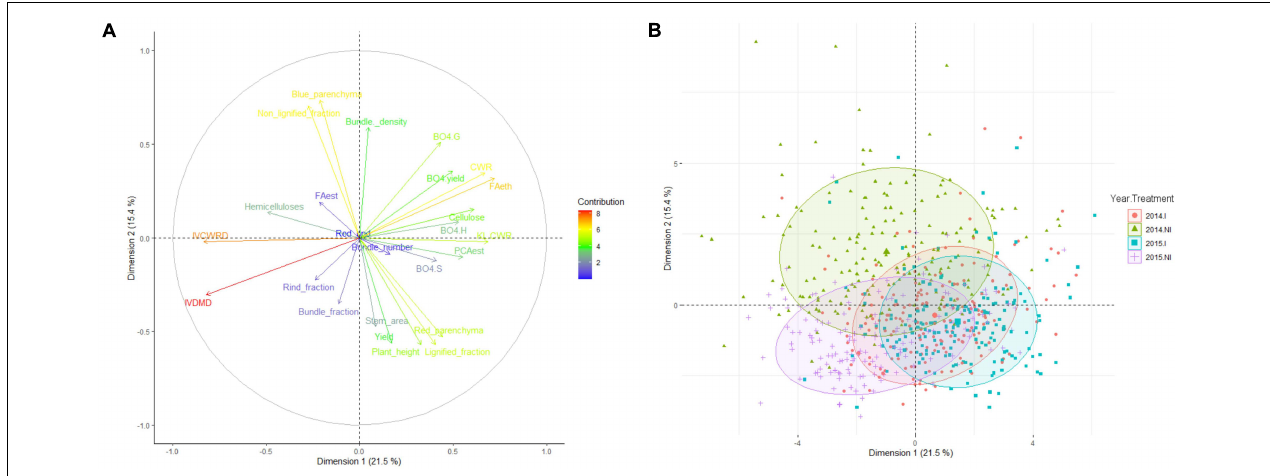
FIGURE 1 | PCA analysis including histological, biochemical, and agronomical traits quantified. (A) Representation of the contribution of each trait in dimension 1 (21% of the global variance) vs. dimension 2 (16.3% of the global variance). (B) Projection of each recombinant inbred line for each year and each irrigation scenario in dimension 1 and 2 area of the PCA analysis. Circles represent the area occupied by 70% of the RIL for each year and treatment